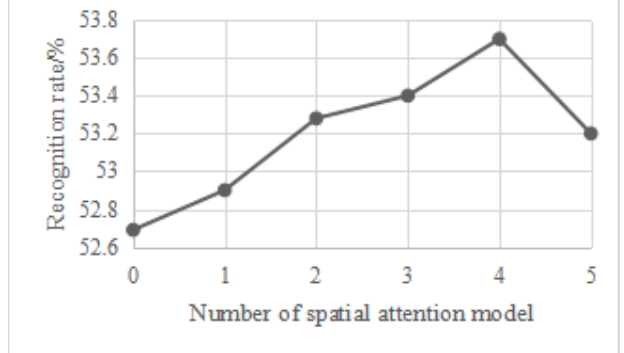
Table 2. Comparison of recognition